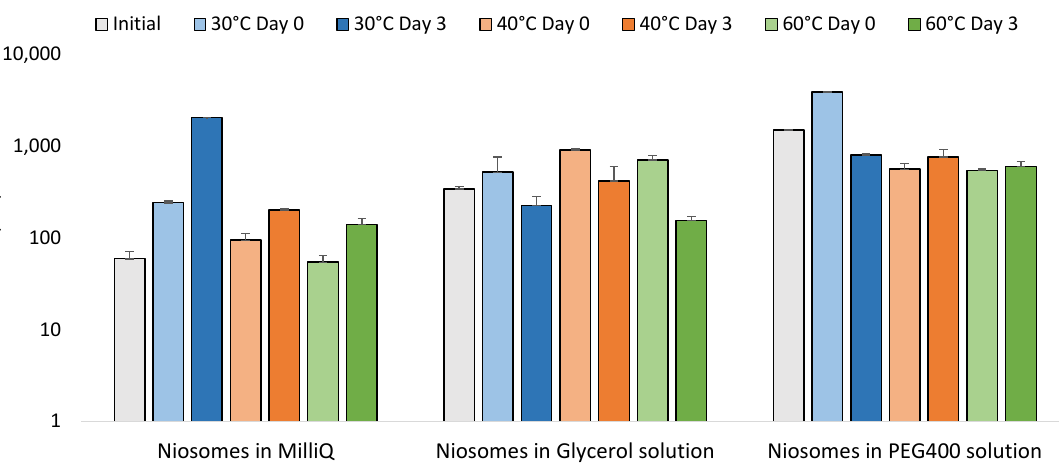
Figure 5. Comparison of size between initial formulations and the formulations at 30 °C, 40 °C, and 60 °C in day 0 and after 3 days.